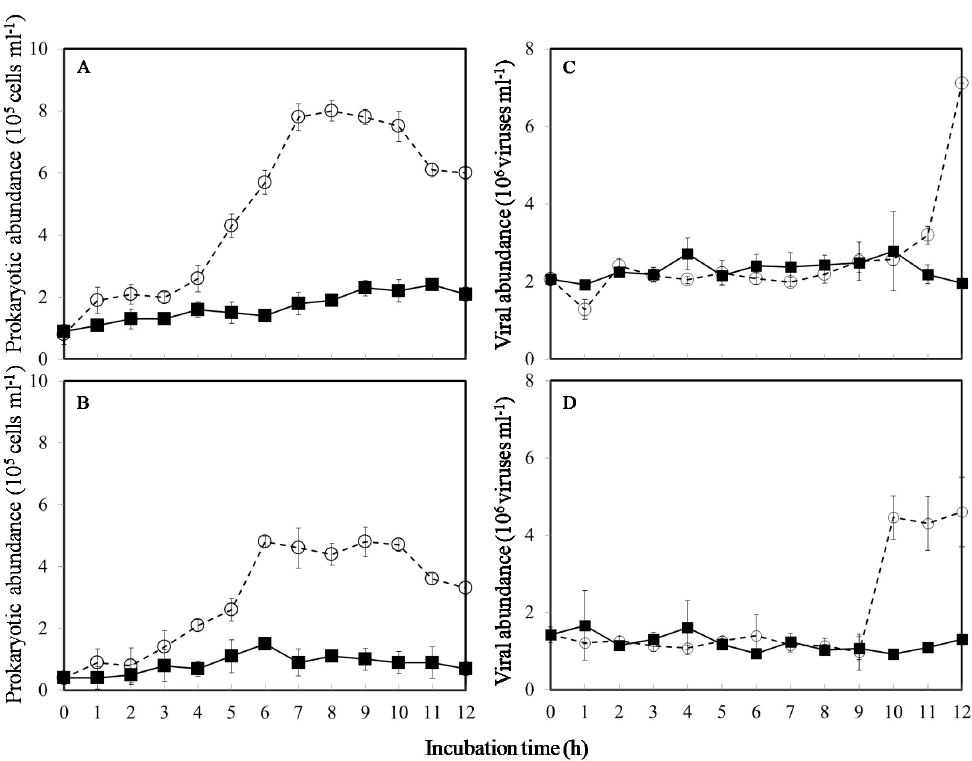
Figure 1. Temporal variations in prokaryotic and viral abundance at ambient ( ■ ), and warming temperature treatments ( ○ ) in November ( A , C ) and December ( B , D ), respectively. Vertical bars show ± standard deviations (n = 3).